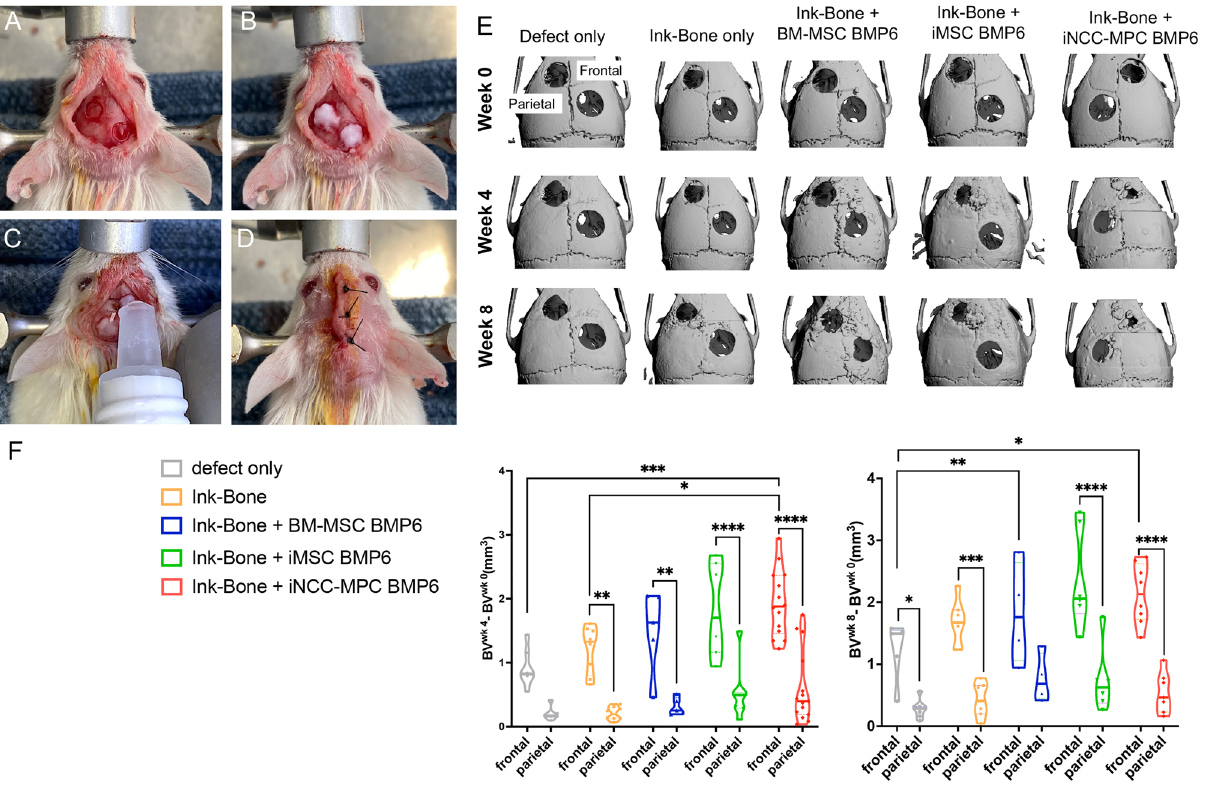
Figure 5. Cranial defect filling with Ink-Bone seeded with iNCC-MPC-BMP6 results in increased bone volume in the frontal bone. ( A ) Surgical approach to create calvarial defects in the frontal and parietal bone. Shown is the fixated cranium with circular defects in the frontal and parietal bone. ( B ) Filling of the defects with Ink-Bone. ( C ) Crosslinking of Ink-Bone using CaCl 2 solution. ( D ) The sutured skin. ( E ) 3D reconstruction